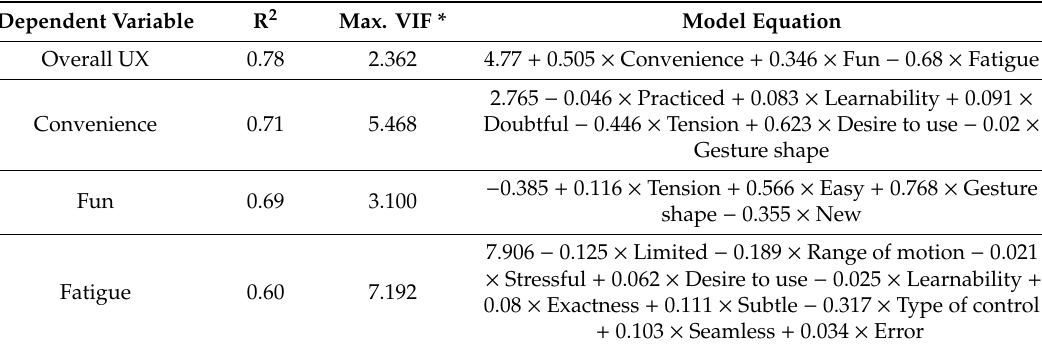
Table 6. Model equations extracted from node